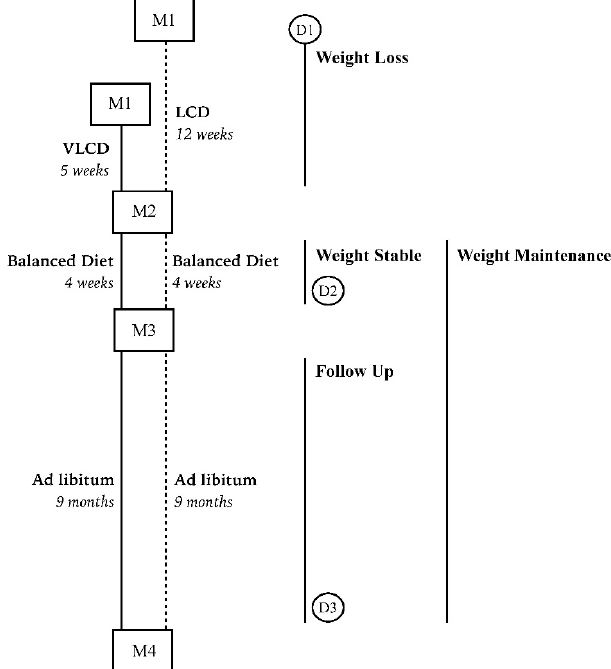
Figure 1. Schematic representation of study design and measurements. Anthropometric measurements M1: before intervention; M2: end of weight loss period; M3: end of weight